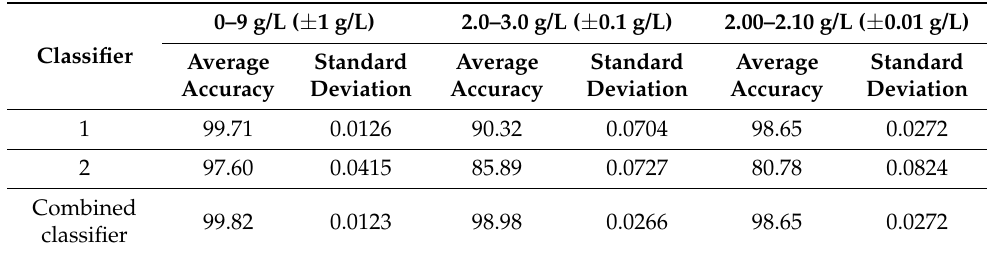
Table 5. Performance of the two classifiers provided by GGA+ELM and the voting system classifier to discriminate the fructose concentrations referred in Tables 1–3. The average values and standard deviation of the accuracy were estimated from 20 M independent and random